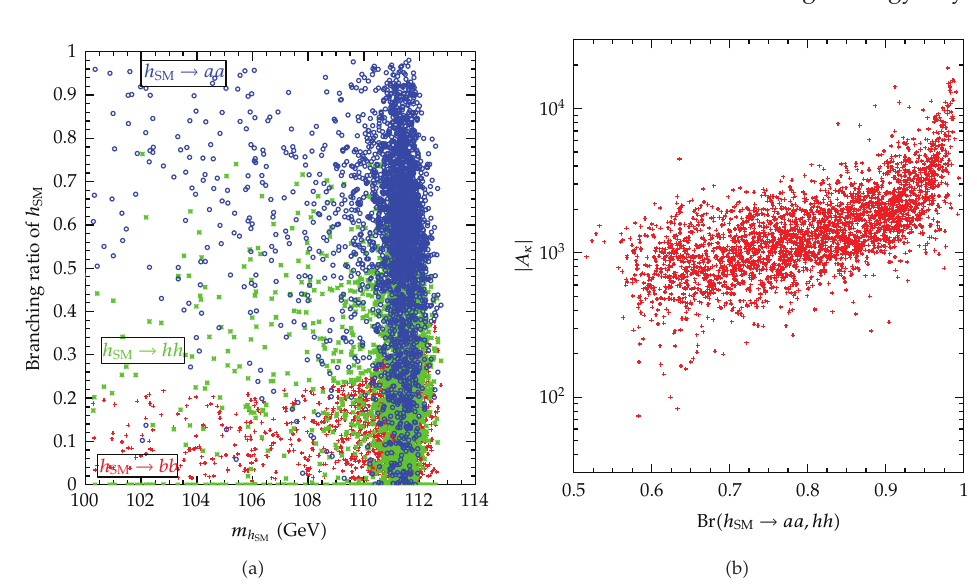
Figure 12: Same as Figure 10, but showing branching ratio of h SM → aa,hh versus m h the branching ratio of h SM → aa,hh (cid:2) taken from (cid:5) 45 (cid:6)(cid:3)